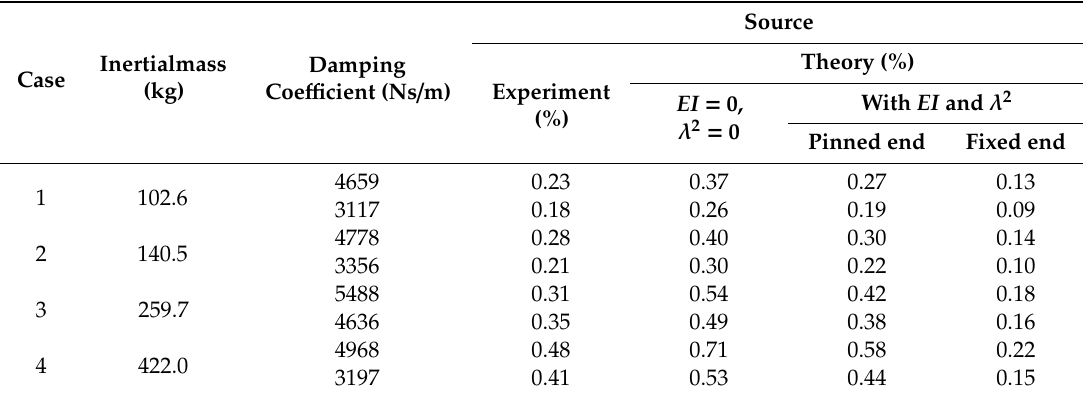
Table 2. The first supplemental modal damping ratio obtained in the theoretical calculation and experimental tests [65].